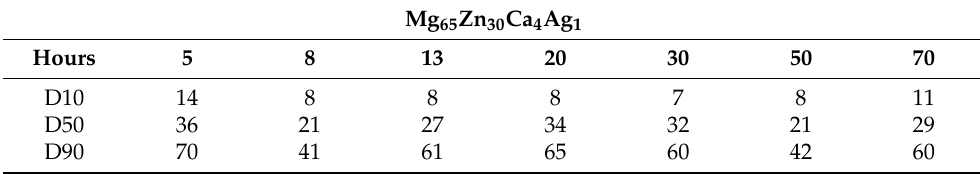
Table 5. Particle size ( µ m) for Mg 64 Zn 30 Ca 4 Ag 2 alloys.